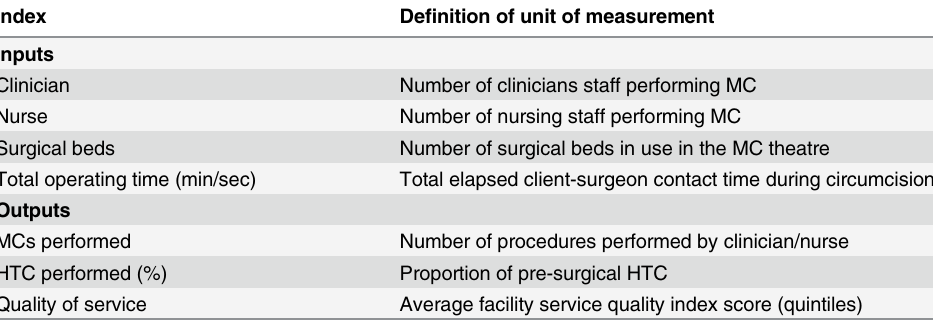
Table 1. Table showing model input and output variables and their de fi